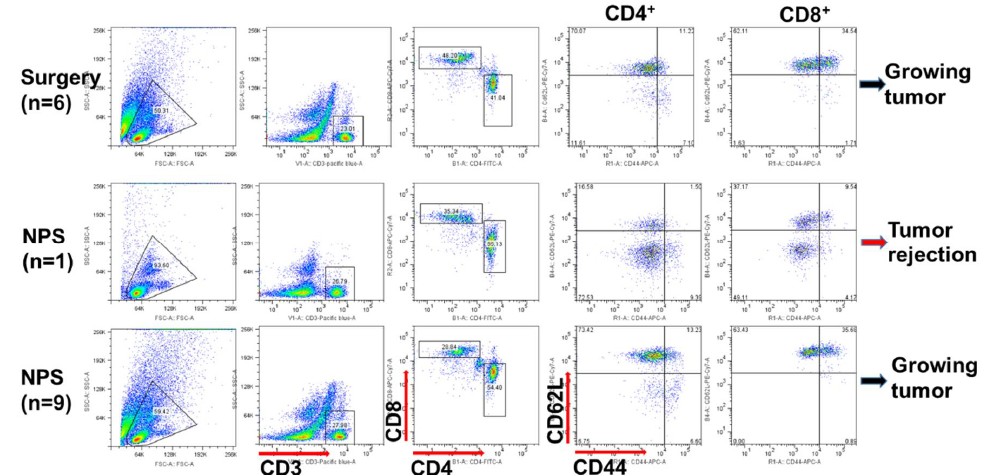
Figure 5. Different T cell responses after NPS treatment. In the abscopal effect experiment blood was collected 13 days after primary tumor was treated either with surgery (Surgery) or with NPS (NPS). One representative flow cytometric graph for the same pattern was shown. ( n = 6, 1, 9): numbers indicate how many animals shared the same pattern.